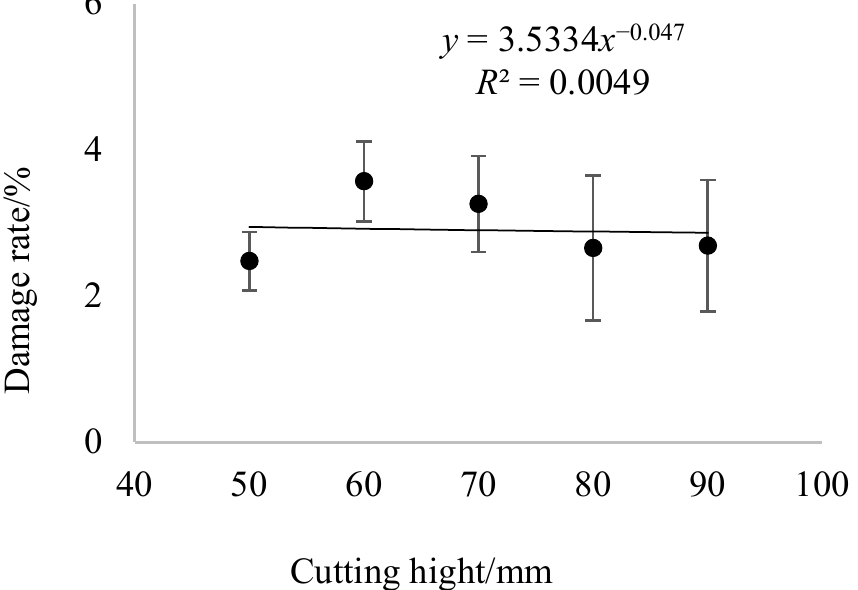
Figure 11. Effect of equivalent friction on damage rate on cutting height. Note: working speed was 1.48 km · h − 1 , digging depth was 90 mm and lifting speed was 0.81 m · s − 1 .